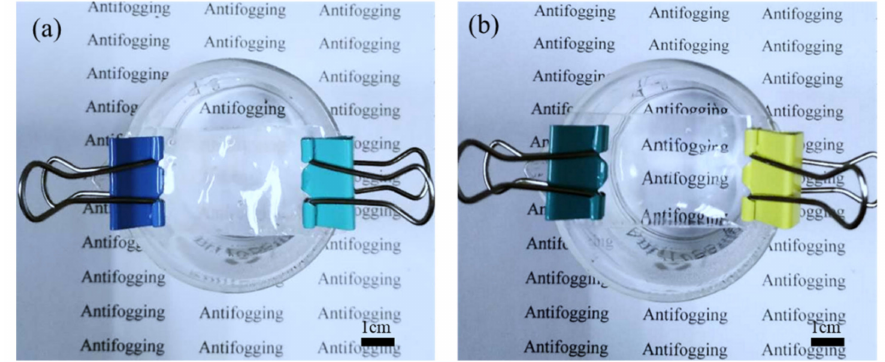
Figure 10. Steam test: ( a ) F-P film; ( b ) C-P film.